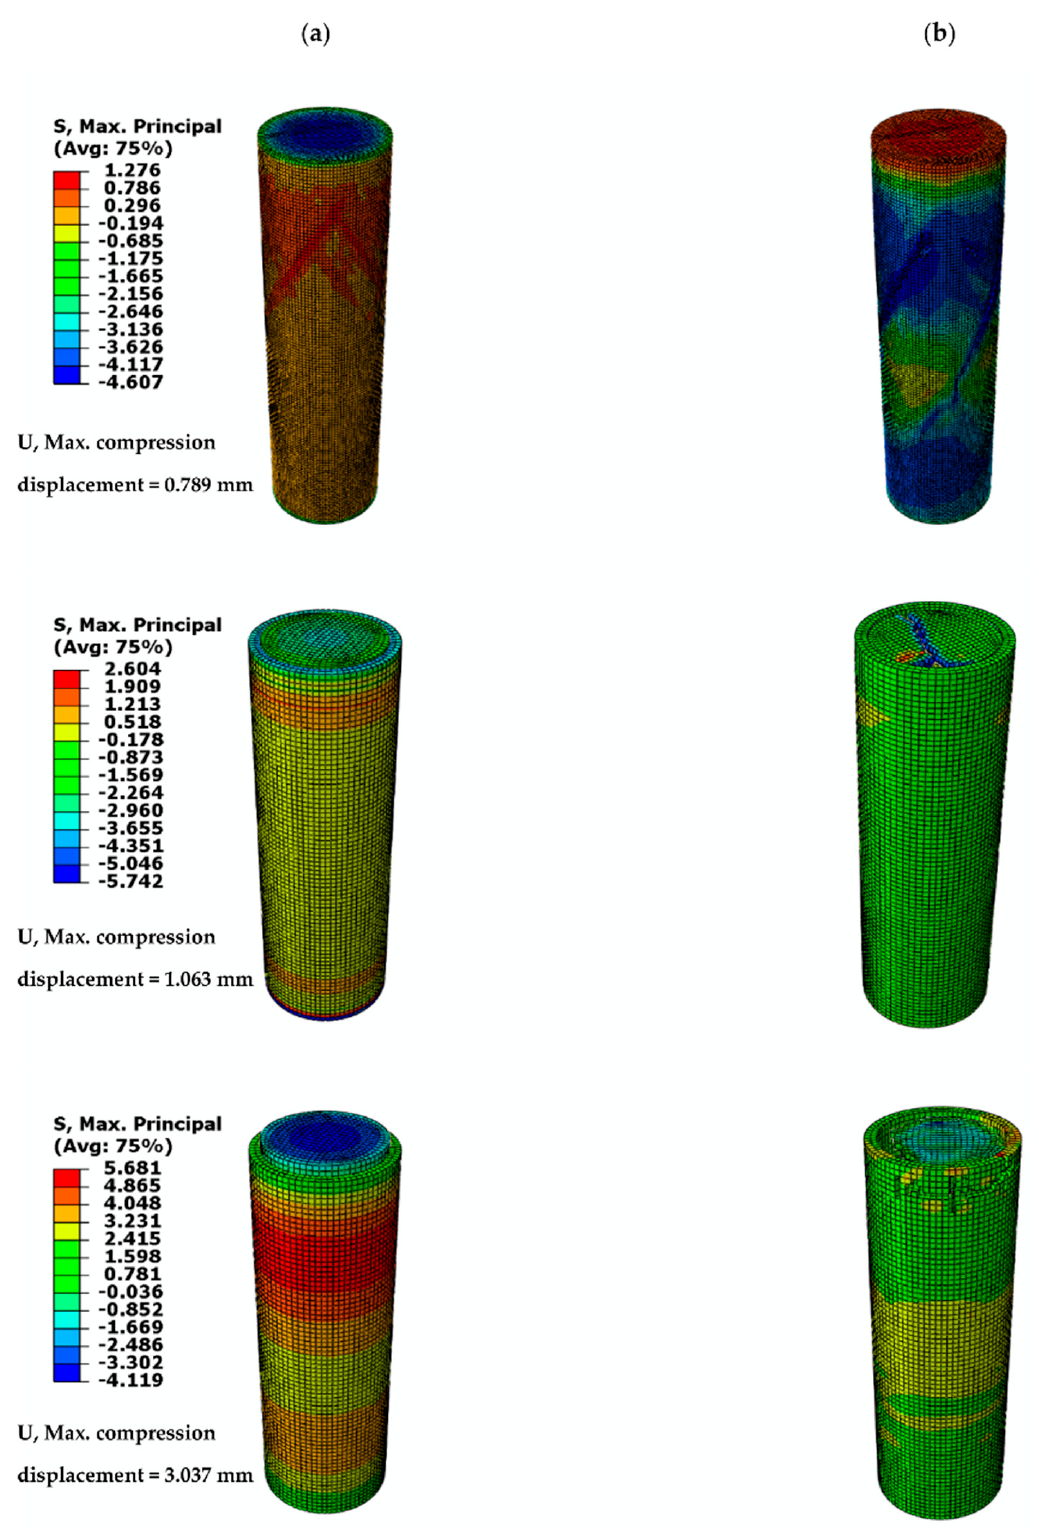
Figure 17. Thefailuremodeof110mmsampleswithmaxprinciplestress. ( a )beforefailure( b )after Figure 17. The failure mode of 110 mm samples with max principle stress. ( a ) before failure ( b ) after failure.